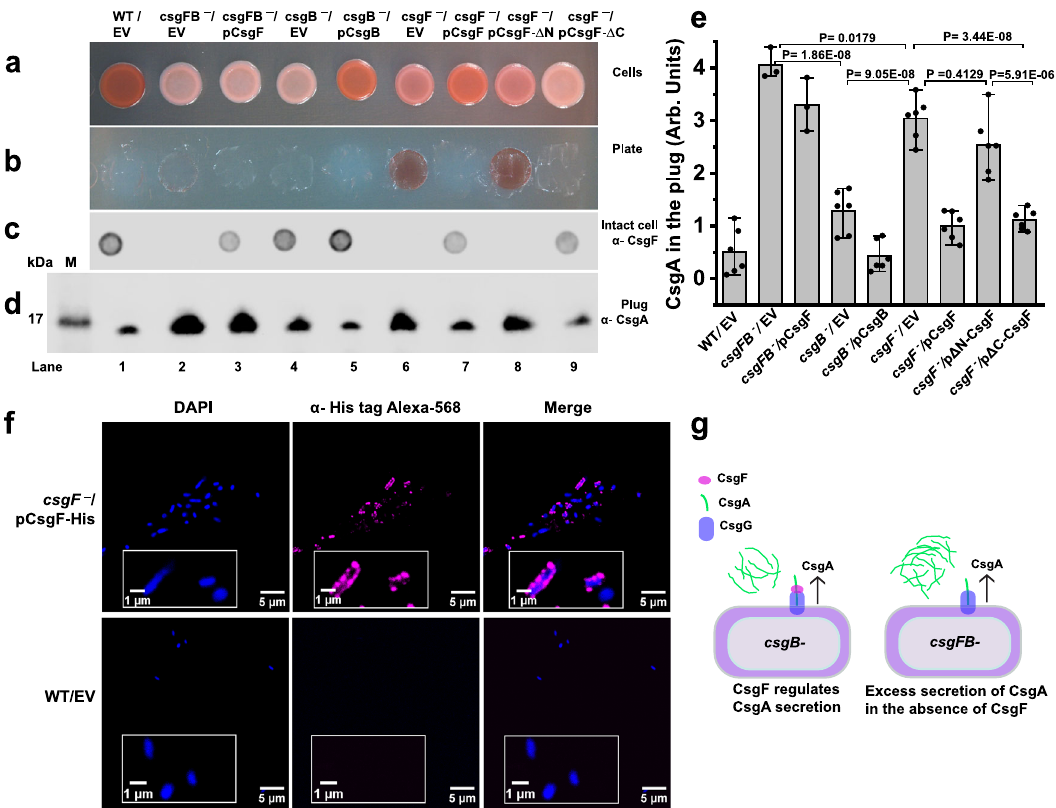
Fig. 5 | Cell surface-associated CsgF regulates CsgA secretion. a Phenotypes of 48hgrownWT/Emptyvector(MC4100/pLR1), csgFB ‒ /Emptyvector( csgFB ‒ /pLR2), csgFB ‒ /pCsgF ( csgFB ‒ /pLR73), csgB ‒ /Empty vector (MHR261/pLR2) csgB ‒ /pCsgB (MHR261/pLR8), csgF ‒ /Empty vector (MHR592/pLR1), csgF ‒ /pCsgF (MHR592/ pLR73), csgF ‒ /pCsgF- Δ N (MHR592/pCsgF- Δ N), and csgF ‒ /pCsgF- Δ C (MHR592/ pCsgF- Δ C) cells on a Congo red YESCA plate. EV: Empty vector. b Agar plate after removingthecellsshownin( a ). c ThedotblotwasperformedusingCsgFantibody onintactcellstoassessthepresenceofsurface-associatedCsgF. d Westernbloton agar plugs that were collected from under the cells after they had grown for